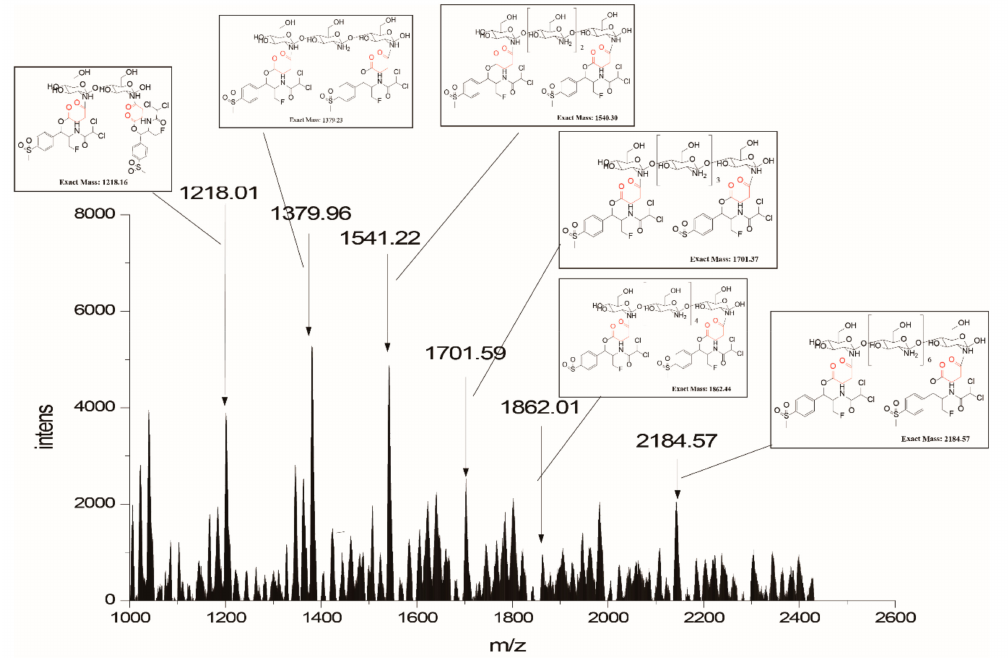
Figure 3. The characterization of F-COS conjugates by MALDI-TOF mass spectrometry in the positive ion mode. 2, 5-dihydroxybenzoic acid was used as the sample matrix.